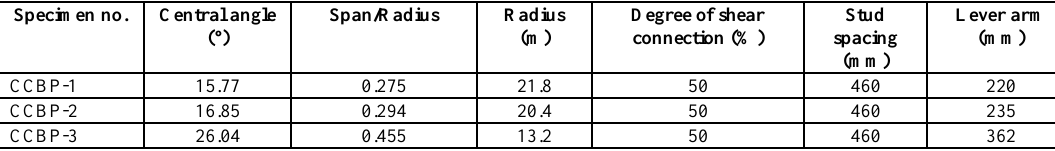
Span/Radius Radius